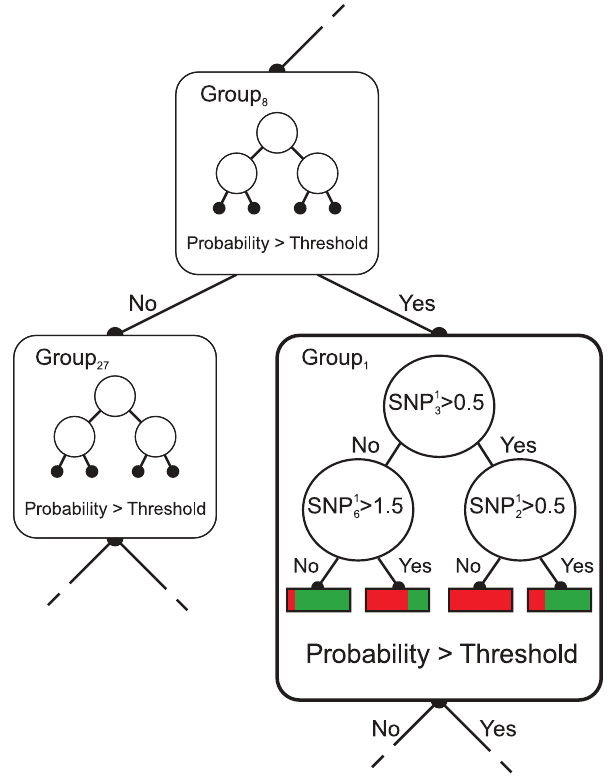
Figure 1. A closer look into a T-Tree test-node. The group 1 is tested. Out of this group, three SNPs are exploited by the weak learner. In red (resp. green), probability of being a case (resp. control) estimated by the